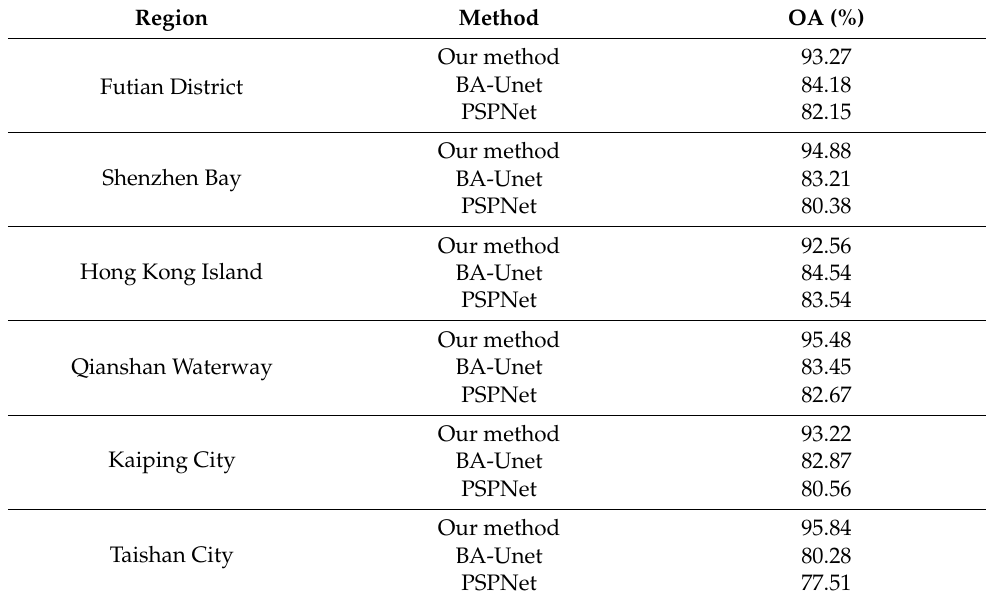
Table 6. Bas extraction accuracy of the six regions by using different deep learning methods.